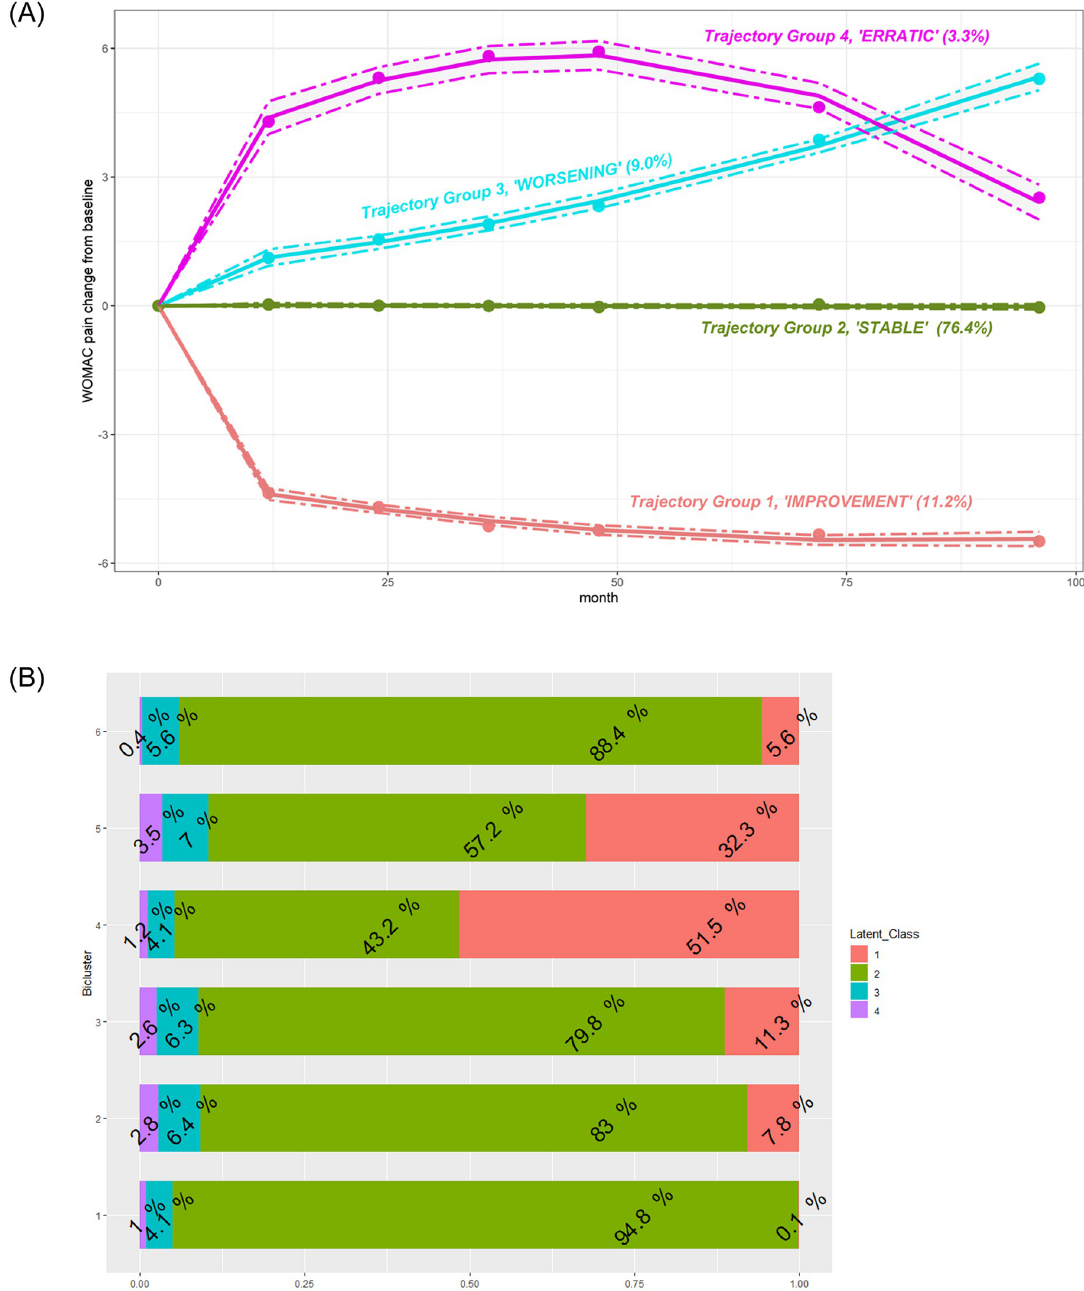
Fig 8. A. Estimated trajectories of WOMAC pain change with 95% confidence intervals (dotted lines) defined by GBTM. Group 1 (red): 11.2% of knees with a mean probability of assignment of 0.94 ± 0.12. Group 2 (green): 76.4% of knees with a mean probability of assignment of 0.95 ± 0.10. Group 3 (cyan): 9.0% of knees with a mean probability of assignment of 0.83 ± 0.16. Group 4 (pink): 3.3% of knees with a mean probability of assignment of 0.88 ± 0.15. See also S1 Fig. B. Assignment to the trajectory by bicluster. Each horizontal bar represents a bicluster. The numbers within the segments of the bar are proportions of knees assigned to a specific trajectory.